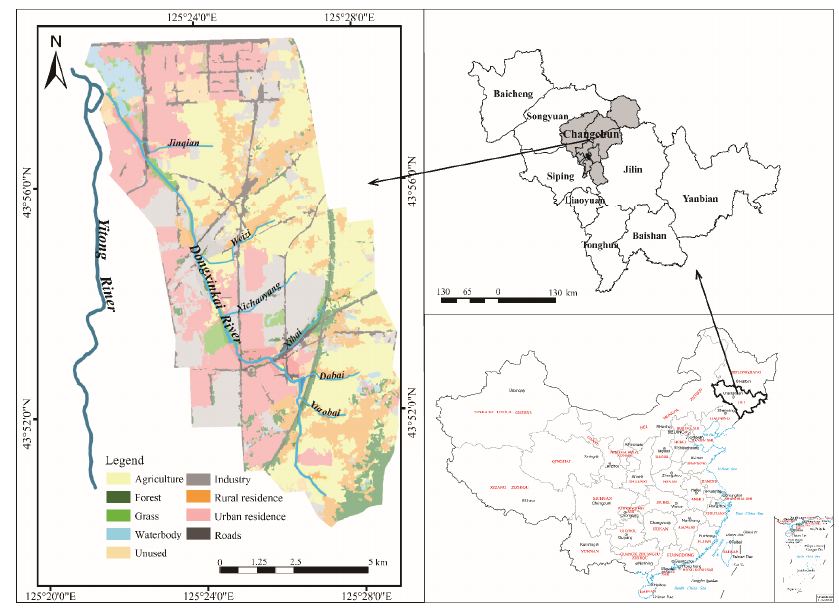
Figure 1. The location of DX River basin. The map of China was downloaded from http://bzdt.ch.mnr.gov.cn/ ( 5 September 2021 ) .